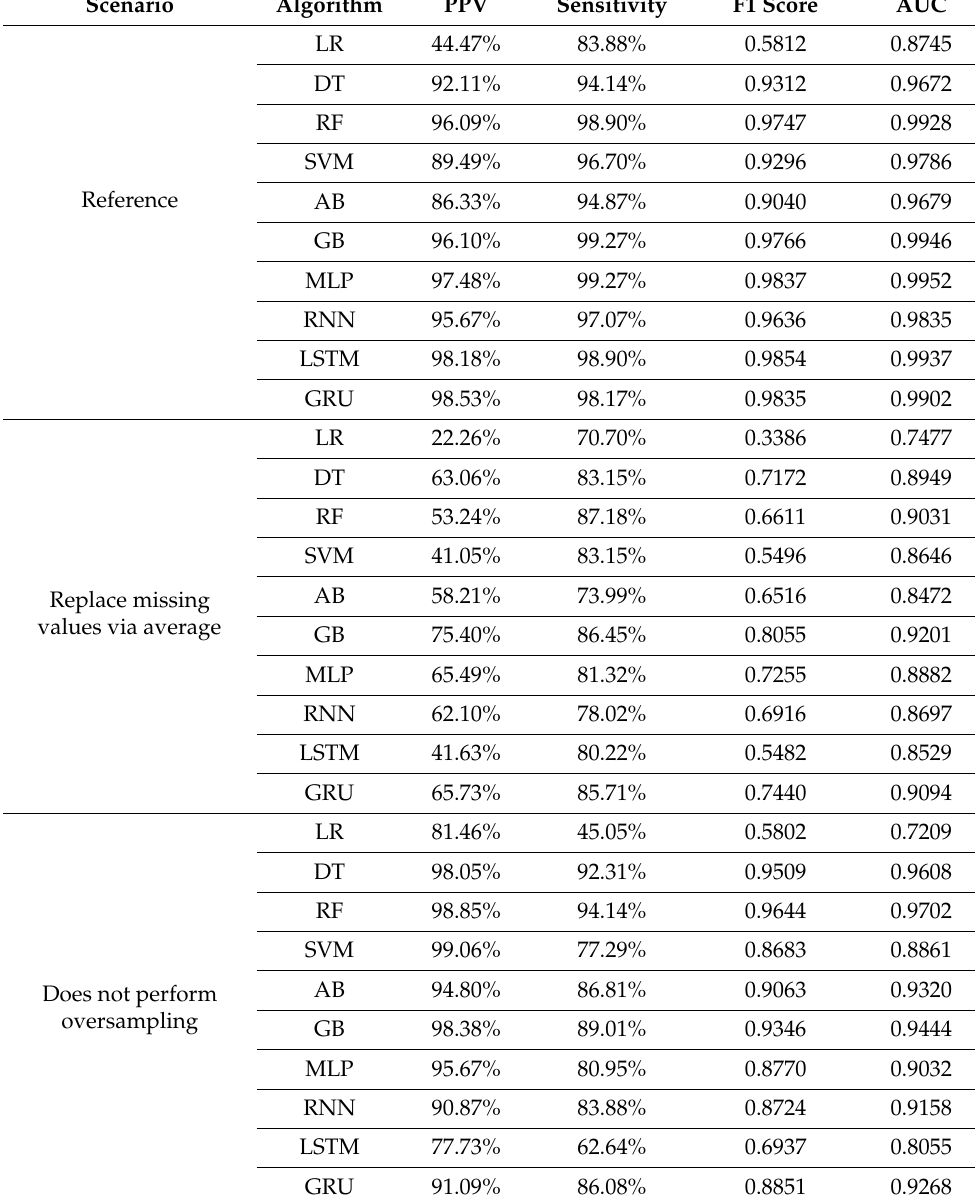
Table 11. Performance result of each